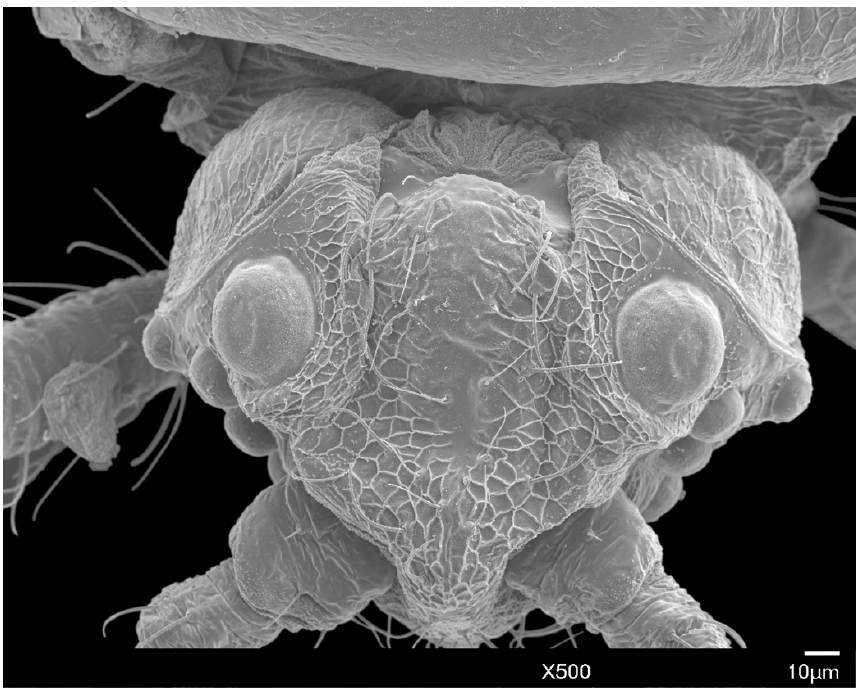
Figure 3. SEM dorsal view of the male A. galliformis head and raised net-like cuticular patterning, showing the dorsal simple eyes, post occipital ridge, post ocular ridge, scape, and genae.